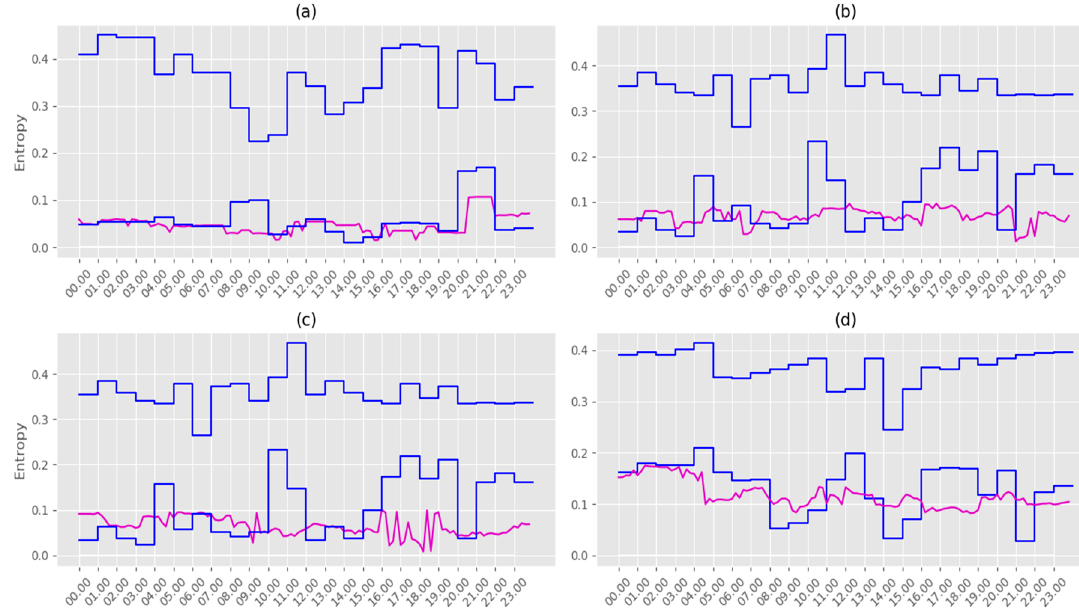
Figure 8. Abnormal day detection in NYC. ( a ) Hallows’ Eve on Wednesday, 31 October 2018. ( b ) Columbus Day on Monday, October 8, 2018. ( c ) Memorial Day on Monday, 28 May 2018. ( d ) New Year’s Eve, 2018.